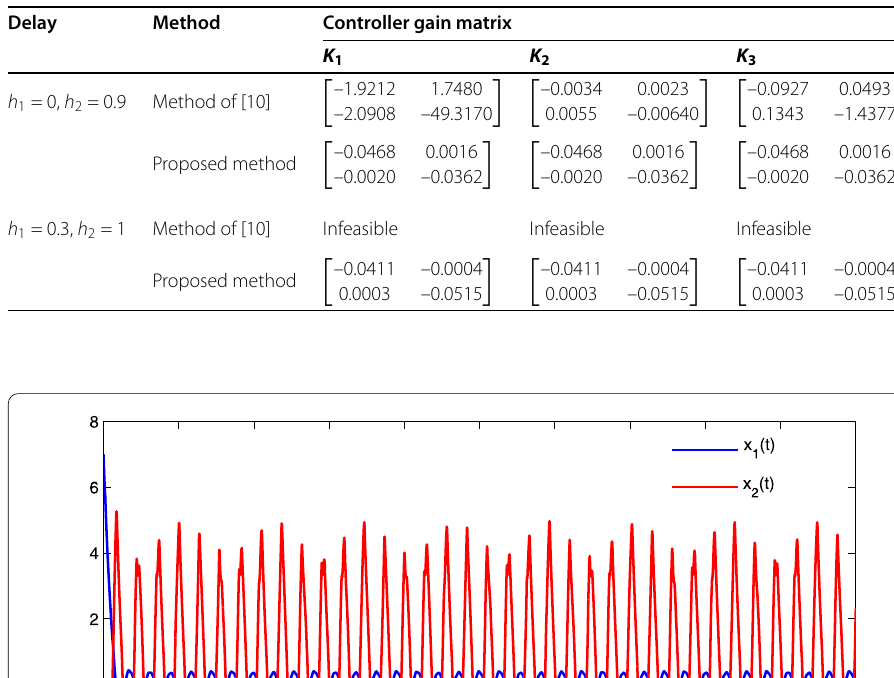
Figure 1 The trajectories of x 1 ( t ) and x 2 ( t ) of nonlinear system (35) with mixed time-varying delay and hybrid intermittent feedback control deactivated.